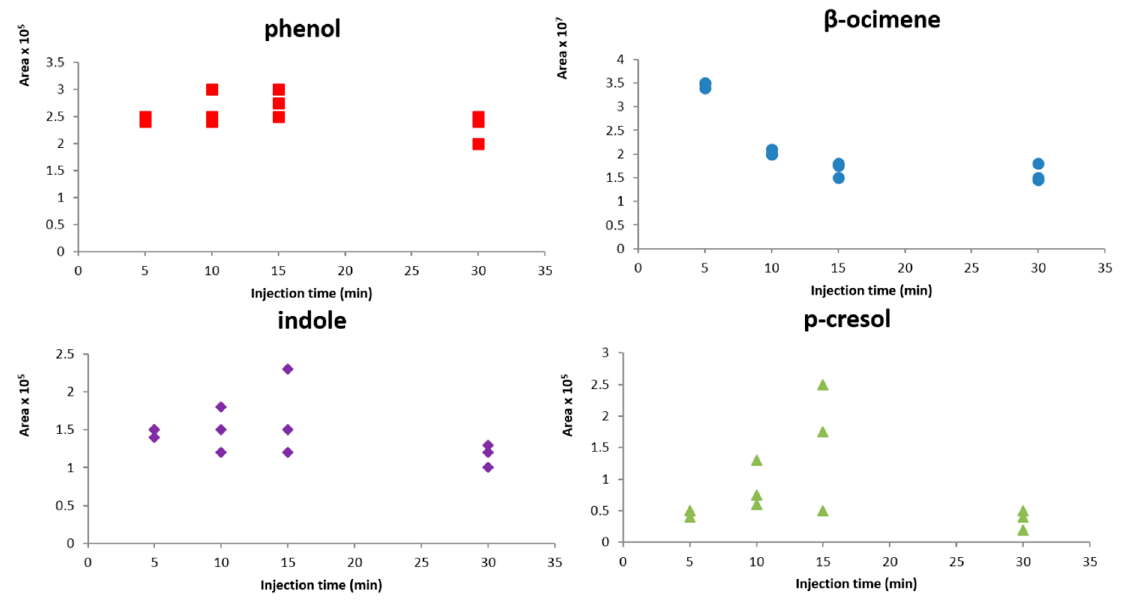
Figure 5. Variation of chromatographic peak area of each bioattractant with injection time (three replicates).